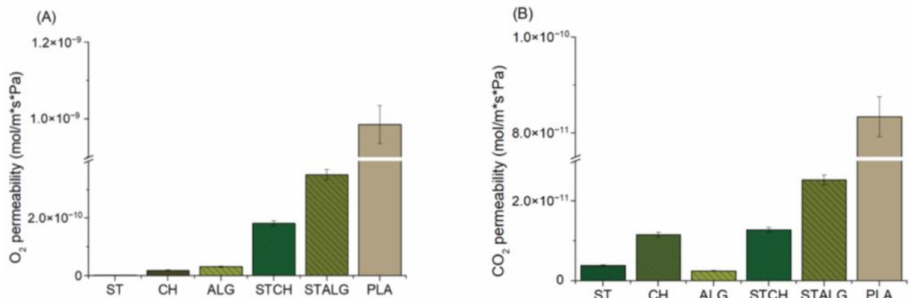
Figure 4. Oxygen ( A ) and carbon dioxide ( B ) permeability of the starch-based (ST), chitosan-based (CH), alginate-based (ALG), starch and chitosan-based (STCH) and starch and alginate-based (STALG) films and the commercially available PLA-based film ( p <